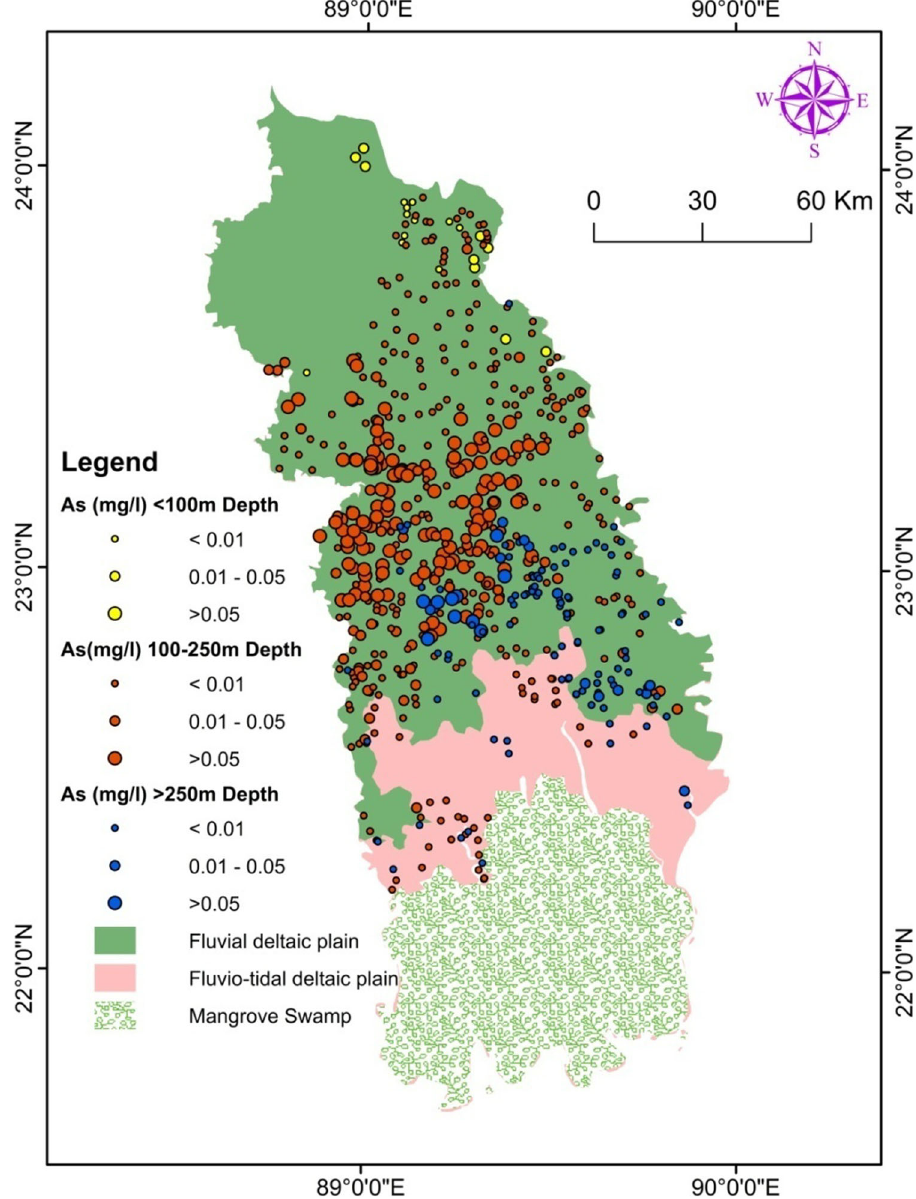
Fig. 10 Spatial distribution map of arsenic concentrations at various depths in relation to